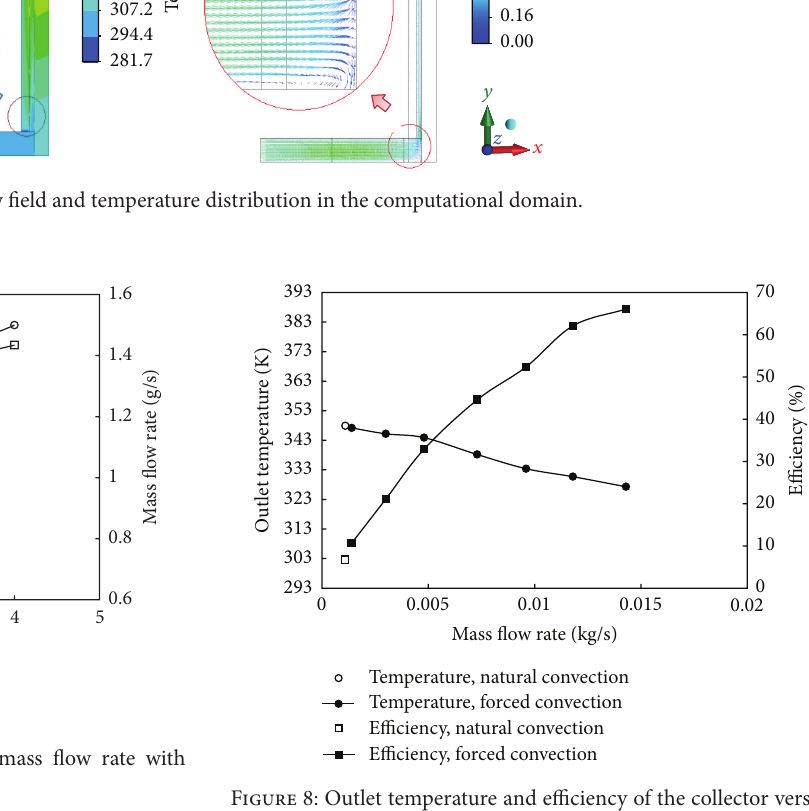
Figure 8: Outlet temperature and efficiency of the collector versus = 20 ∘ mass flow rate at 𝑇 𝑖 = 𝑇 amb .